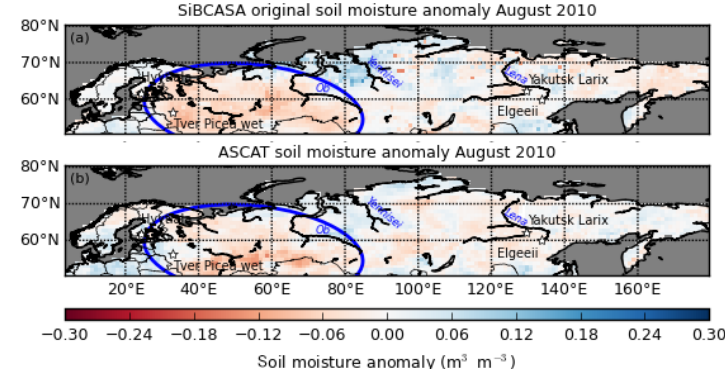
Figure 9. Monthly mean soil moisture in (a) SiBCASA and (b) ASCAT in August 2010. The ellipse shows the extent of the 2010 drought according to SiBCASA.